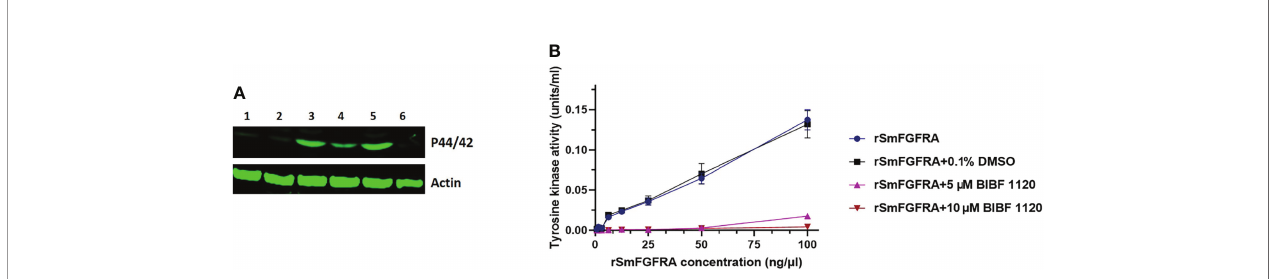
FIGURE 7 | (A) Effect of human aFGF or bFGF on the stimulation of extracellular signal regulated kinases 1 and 2 (Erk1/2) in adult S. mansoni worms. An anti-phospho p44/42 MAPK (Erk) antibody (upper panel) and an anti-actin antibody (lower panel) were used to probe a protein extract of wild type, untreated adult worms (Lane 1) and worms which were incubated with 0.1% DMSO (Lane 2), human bFGF (Lane 3), human aFGF (Lane 4), both human bFGF and aFGF (Lane 5), and 10 m M BIBF 1120 (Lane 6), respectively. (B) Tyrosine kinase activity of rSmFGFRA at different concentrations (0-100 ng/µl) in the presence or absence of 0.1% DMSO or BIBF 1120 (5 µM and 10